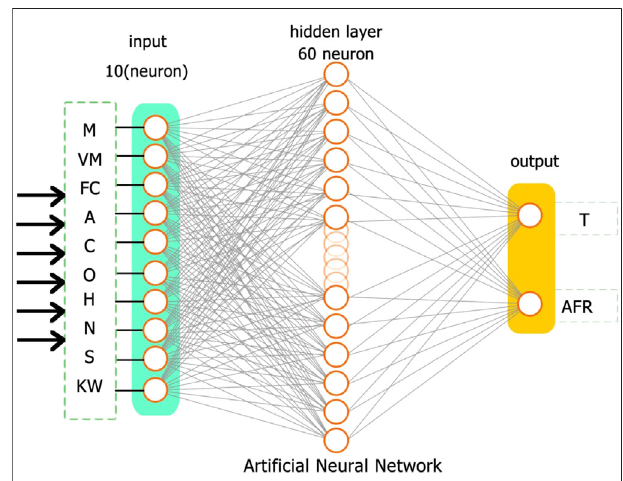
FIGURE3| ANNmodelarchitecturetoestimatetheprocessparameters for the integrated downdraft biomass gasi fi cation process with a power generation